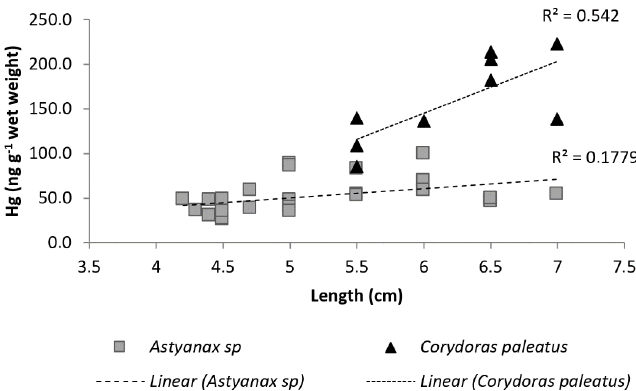
Figure 2. Relation between Hg concentration in Astyanax sp (n = 25) and Corydoras paleatus (n = 10) tissues and sizes sampled from a paddy.